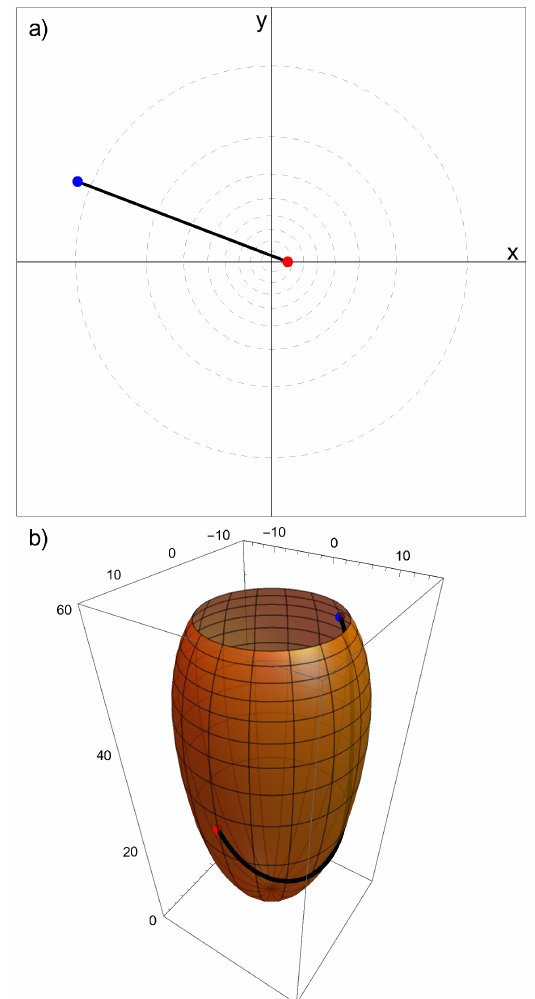
Figure 6. ( a ) geodesic stereographic projection on E 2 of the geodesic arc of great circle on S 2 connecting the same red point at coordinates ( w = 0.25, φ = 0) with the same blue point at coordinates ( w = 13 π φ = 7 π ); ( b ) diffeomorphic image on V 1 of the geodesic arc of great circle connecting the red and blue 8 points on the S 2 visual field. A = 525.6 and B =